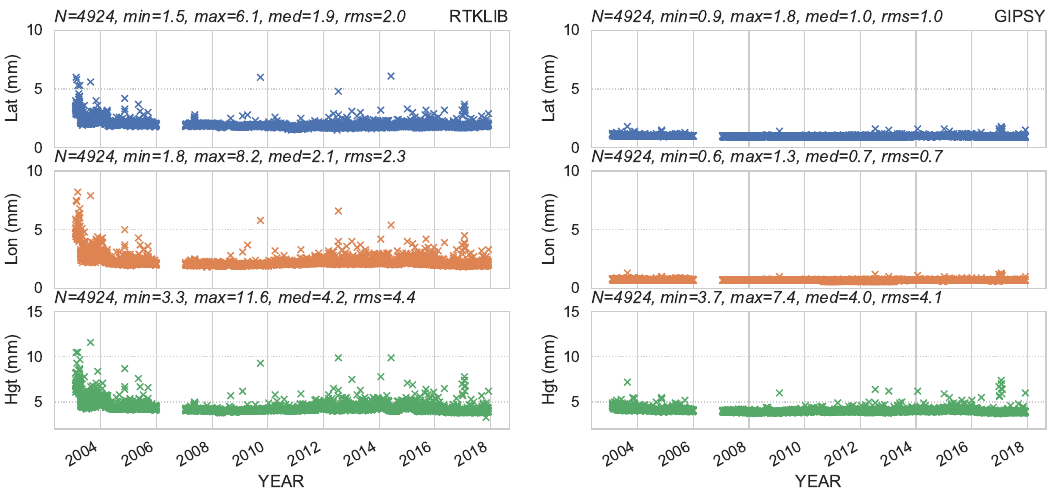
Figure 8. Internal precision in terms of standard deviation of the two solutions: RTKLIB ( left ) and GIPSY ( right ) [unit: